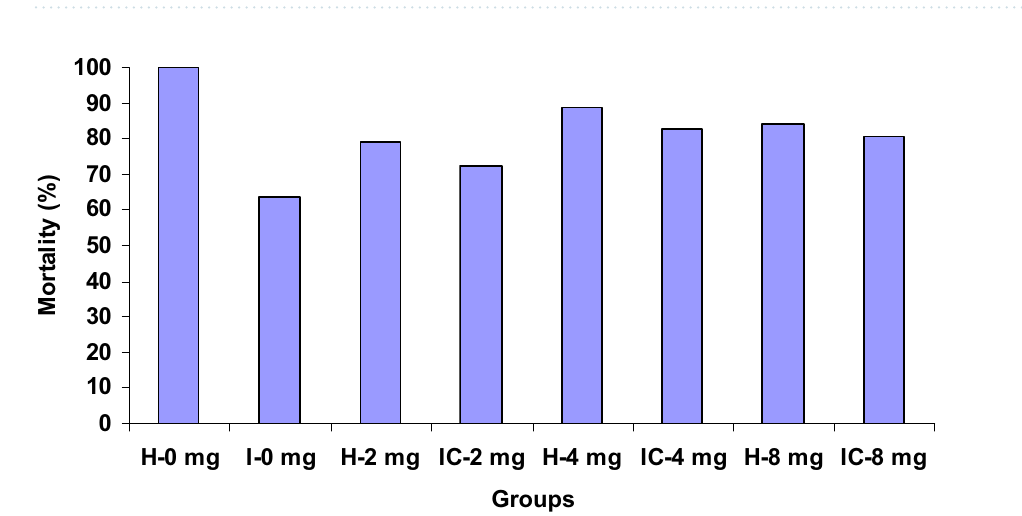
Figure 12. Expression pattern of ( a ) NOD1 and ( b ) NOD2 relative to β-actin in the head kidney of catla (n = 3) against A. hydrophila . H healthy, I infected. Values are expressed as mean ± SD and the statistical difference between means ( P < 0.05) indicated in different letters in each column.